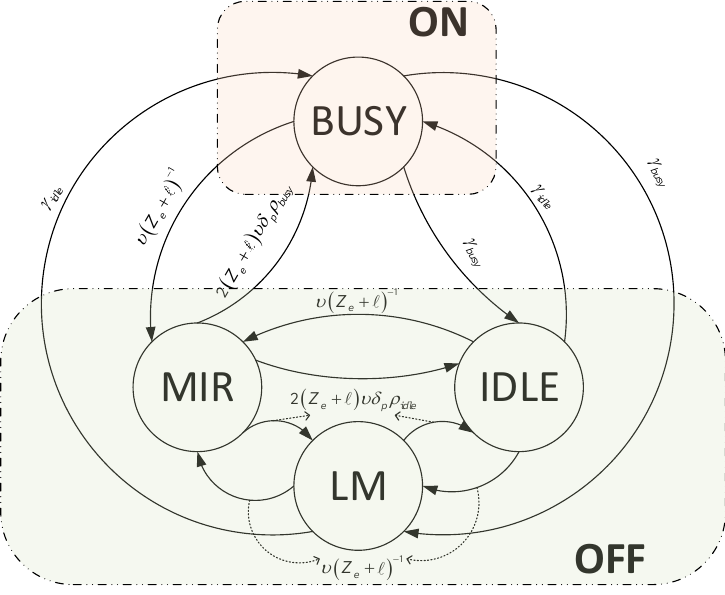
Figure 1. Mobile reliable opportunistic routing (MROR) channel availability